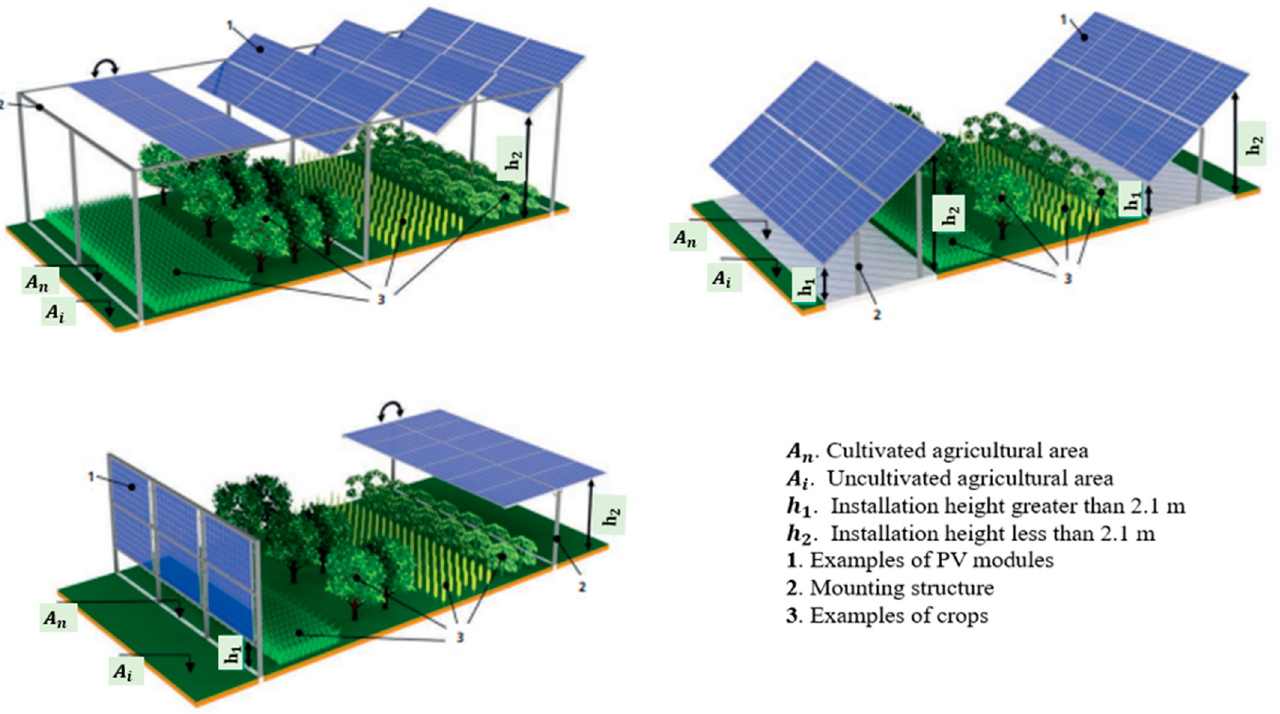
Figure 2. Overview of different configurations of agrivoltaic installations [44].